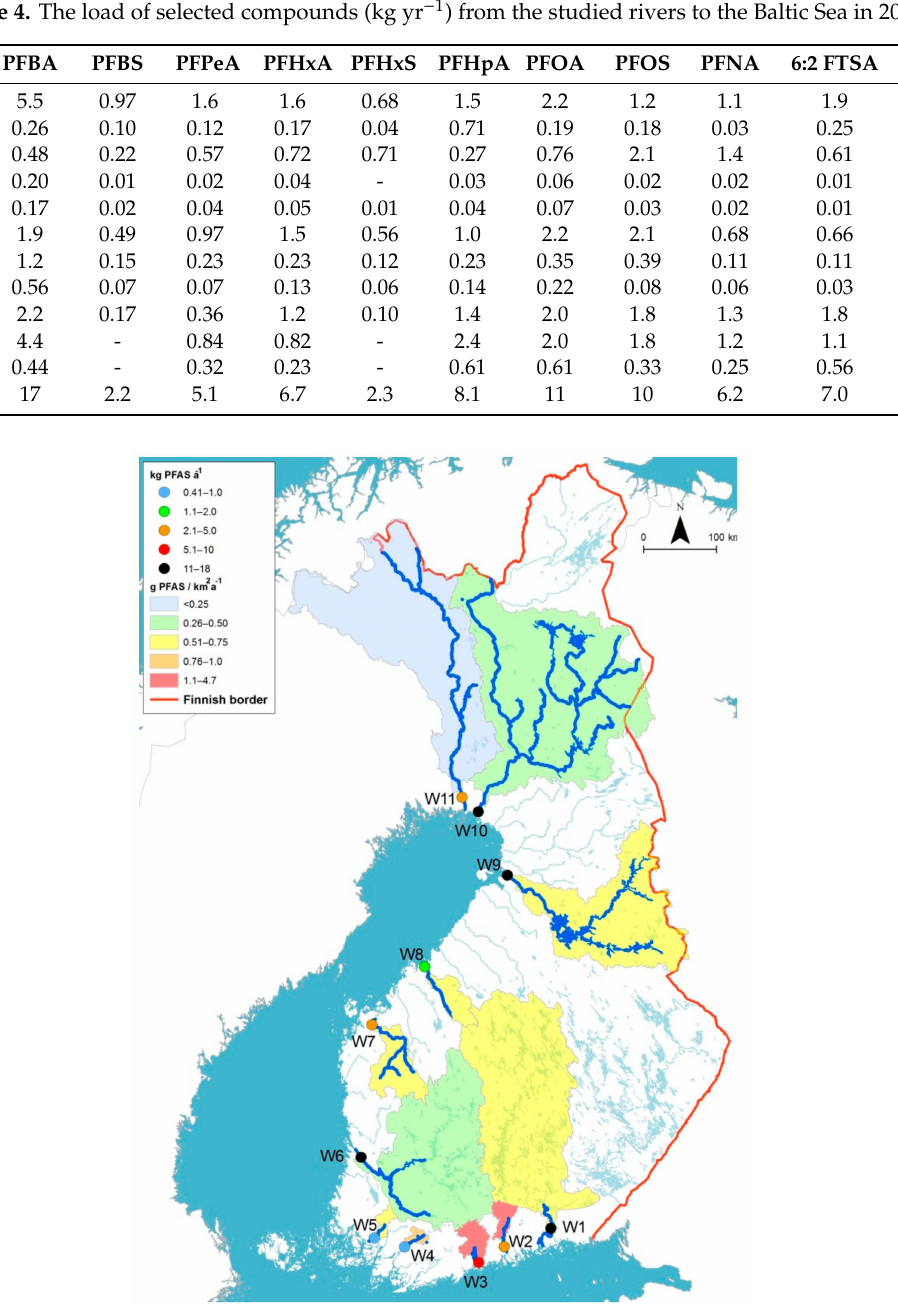
(cid:80) 10 PFASs of the studied